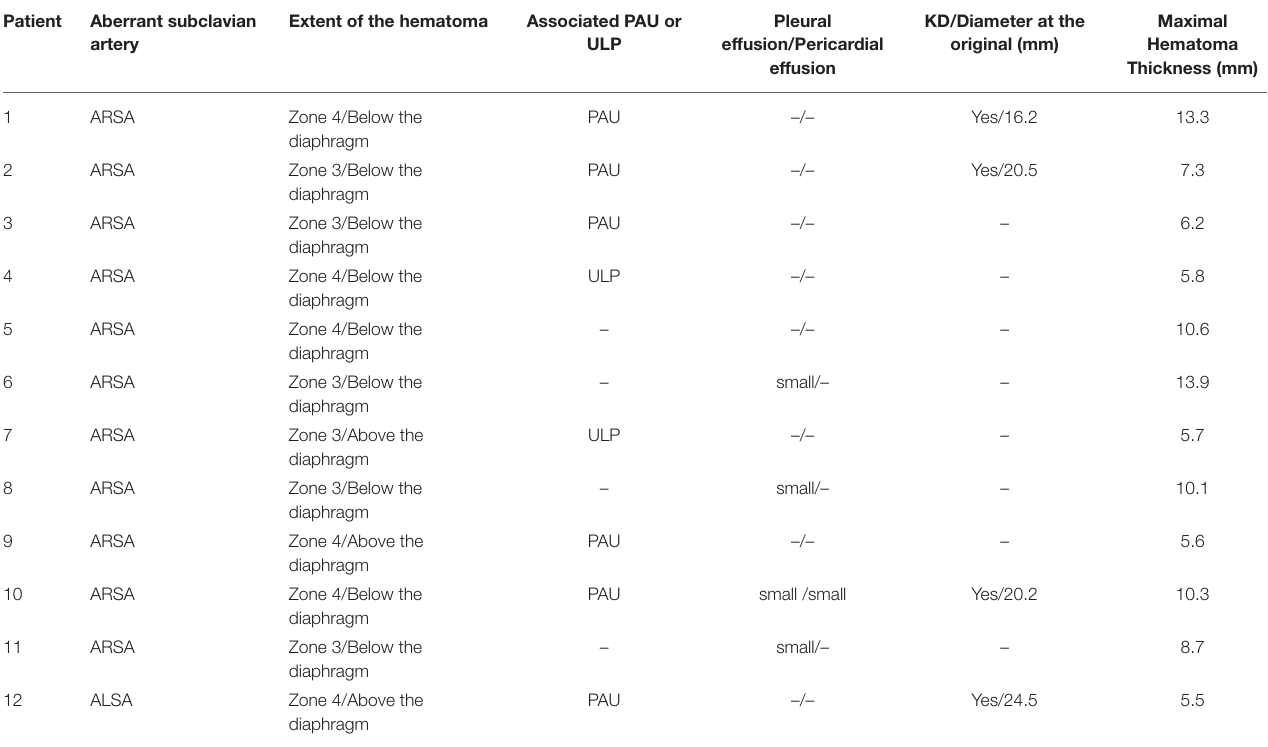
TABLE 2 | Image data of initial contrast-enhanced CT angiogram (CTA).